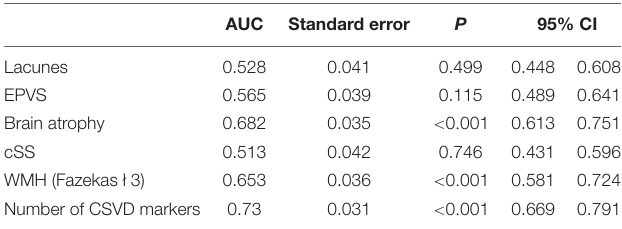
TABLE 3 | Evaluation of the predictive value of CSVD markers using